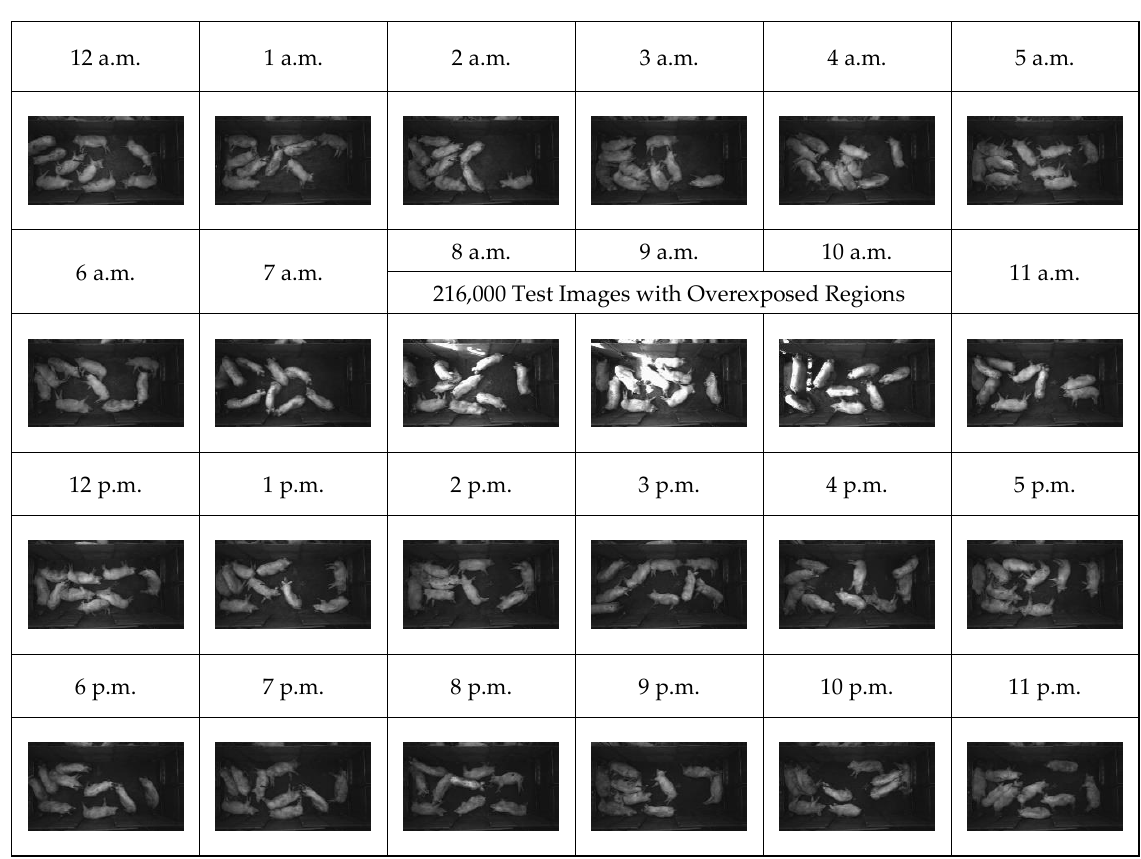
Figure 1. Infrared images obtained from a closed pig pen at each hour. From 8:30 a.m. to 10:30 a.m., overexposed regions (with grey pixel values higher than 240) caused by sunlight can be observed. To solve this issue, the training images do not include overexposed regions, and the test images include overexposed regions. Practical accuracy metrics are also proposed for evaluating the detection accuracy with 216,000 test images, without box-level annotation.